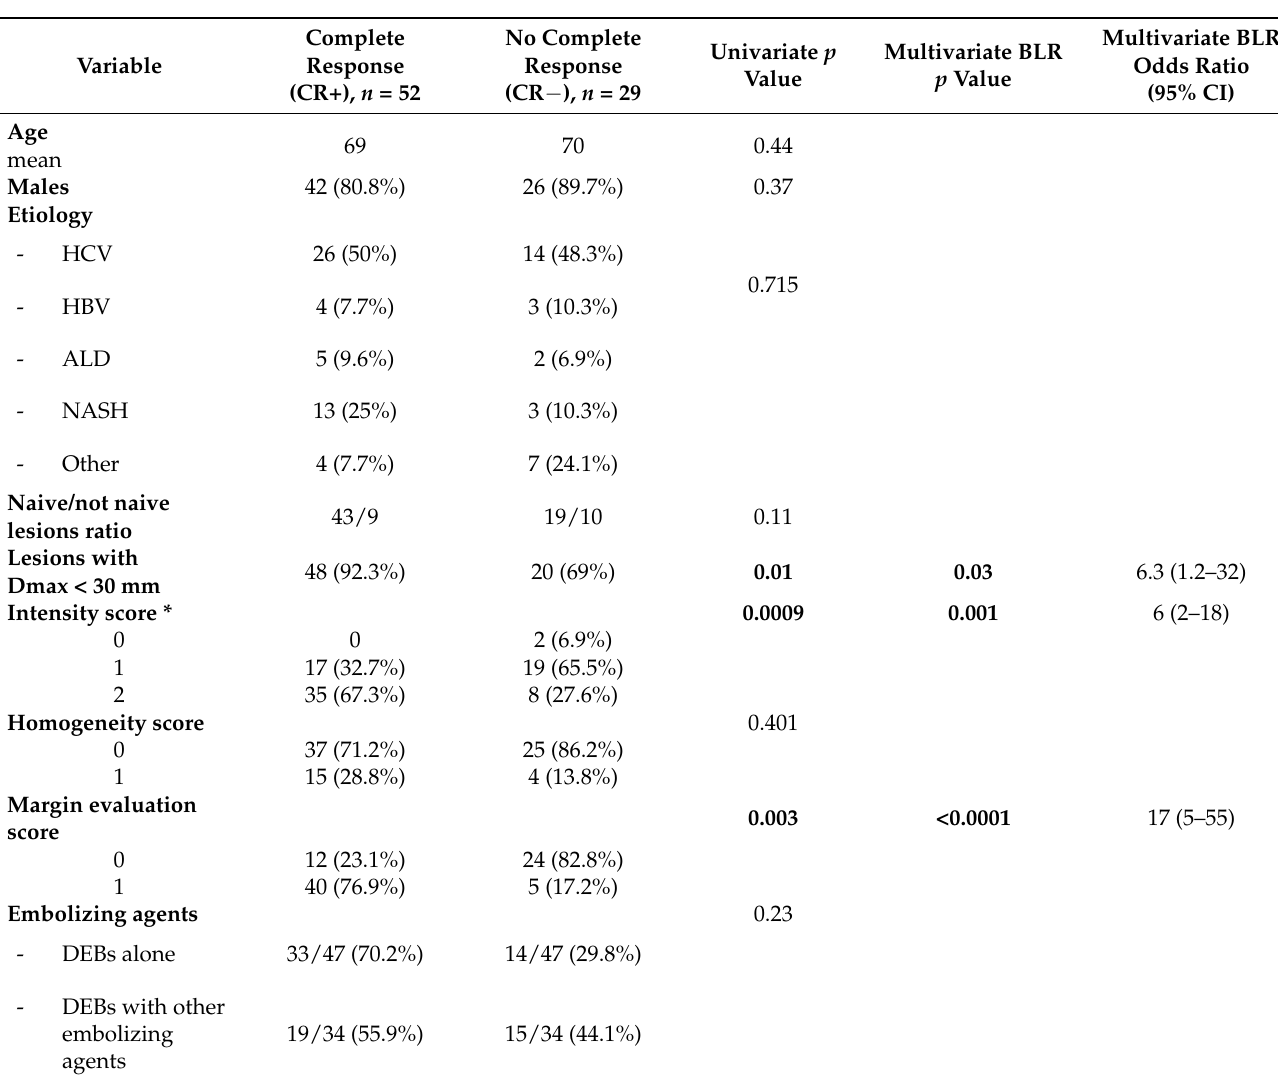
Table 1. Univariate analysis and binary logistic regression (BLR) of demographics, clinical data, and lesion features. CR+ vs. CR −